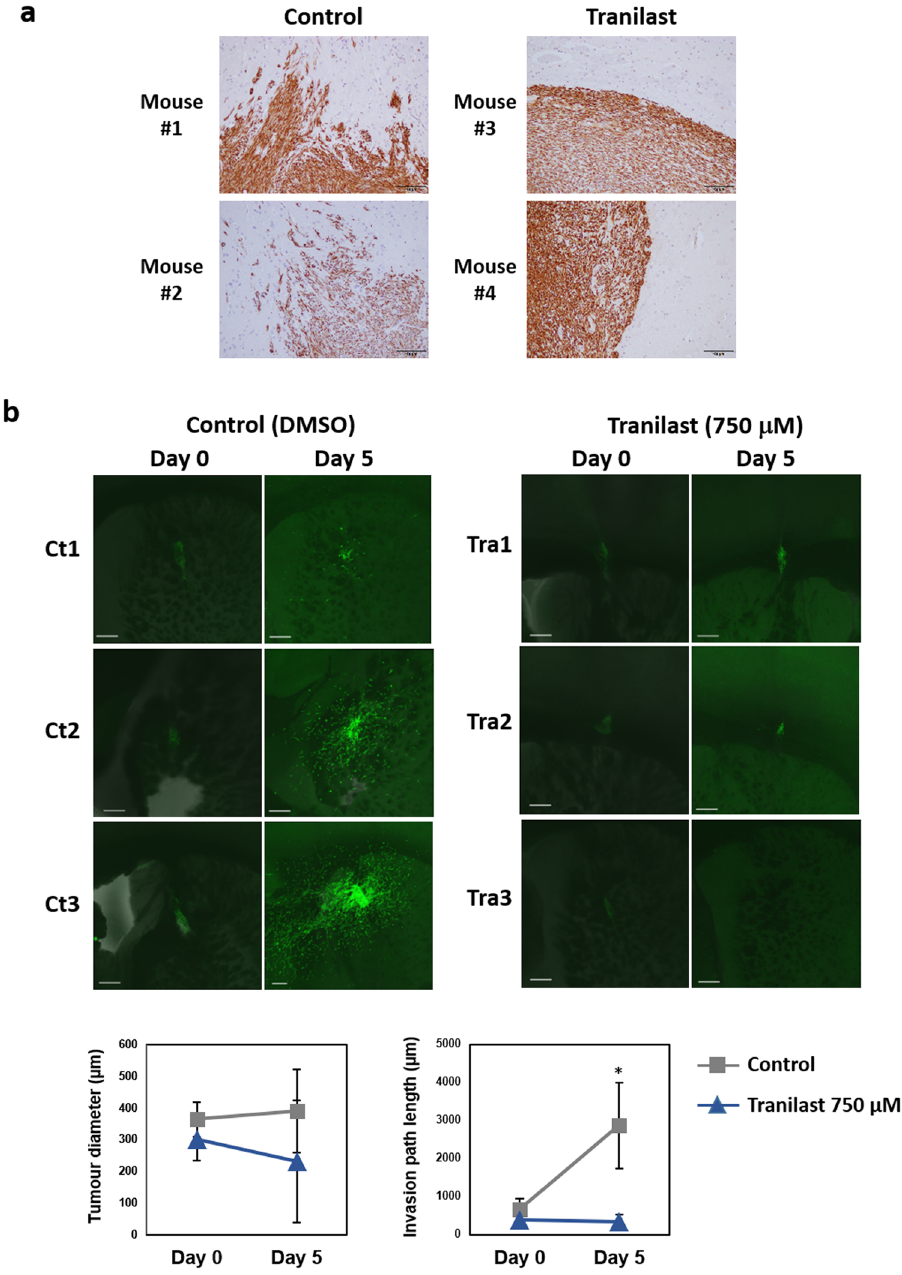
Figure 6. Tranilast inhibits sNF96.2 cell proliferation and invasion in brain tissue. ( a ) sNF96.2 cells were injected into the brain of NOD/SCID mice. After 3 weeks, the mice were treated orally with tranilast (300 mg/ kg) or vehicle once a day for 8 weeks. The brain was then removed from four representative mice, and formalin- fixed, paraffin-embedded sections of the xenograft tumours were subjected to immunohistochemical analysis with antibodies to vimentin. Scale bars, 100 µ m. ( b ) sNF96.2-GFP cells were injected into the brain of NOD/ SCID mice. After 6 weeks, the brain was removed and thin slices of brain tissue containing tumour cells were cultured in medium containing tranilast (750 µ M) or DMSO vehicle for 0 or 5 days, at which times the same areas (Ct1–3 and Tra1–3) were examined by confocal fluorescence microscopy and photographed. Scale bars, 300 µ m. Maximum tumour diameter and maximum length of the invasion path were determined from the images. Data are means ± s.d. ( n = 3). * P < 0.05 versus corresponding tranilast value (Student’s unpaired t